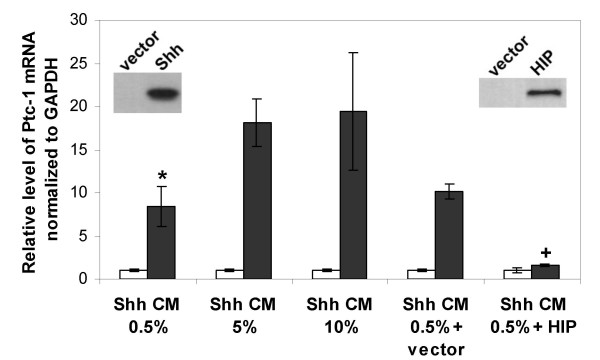
Expression of HIP in responding cells blocks Ptc-1 induction by Shh. Untransfected mouse TM3 cells (first three pairs of columns) or TM3 cells transfected with empty vector or a vector expressing mouse HIP (last two pairs of columns) were exposed to Shh conditioned media at the indicated concentrations (% v/v in normal growth media) for two days, after which Ptc and GAPDH mRNA levels were measured by Q-RT-PCR. Ptc-1 mRNA level was then normalized to that of GAPDH. Values shown for Shh conditioned media treatment (filled bars) are normalized to those obtained with mock conditioned media (open bars). Results shown are the mean of three experiments performed in duplicate. Error bars show standard deviation. The decrease in normalized Ptc mRNA level for mock- vs. Shh-treated (*) and for HIP- vs. vector-transfected (+) cells was statistically significant (p < 0.005, two-tailed Student's t-test). Left inset, Western blot showing Shh protein expression in conditioned media from Shh-transfected 293-EBNA cells. Right inset, Western blot showing HIP protein expression in conditioned media from HIP-transfected TM3 cells.